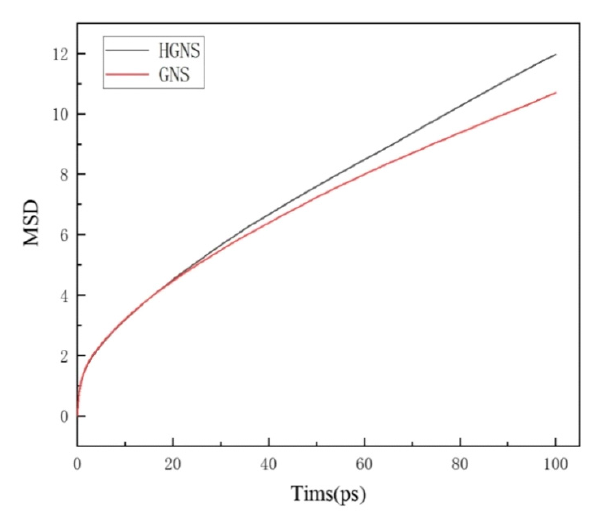
Figure 7. Mean square displacement (MSD) vs. t for lithium ions in the two different systems. Table 5. Diffusion coefficients (in cm 2 /s) of Li + and solvent molecules in the two systems. Li + EC